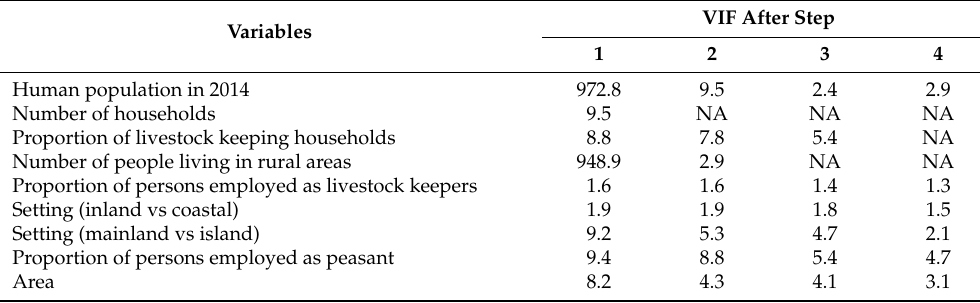
Figure A3. Dog population size estimates for the 28 districts. Data for the household survey were collected in 2011 (different dog vaccination campaigns), while school-based survey and transects were conducted in 2014 and 2015 following the dog vaccination campaigns. Points are the mean estimate and error bars show the 95% confidence intervals (CIs) around the mean. We did not report CIs for districts where less than three dog-owning households were sampled, or where surveys were not administered. Table A1. A stepwise comparison of variance inflation factors (VIFs) for variables that may influence dog populations in Tanzania. Predictor variables with highest VIF values were removed, and the stepwise comparison repeated until all VIF values were below 5. NA = not applicable after the predictor was dropped.